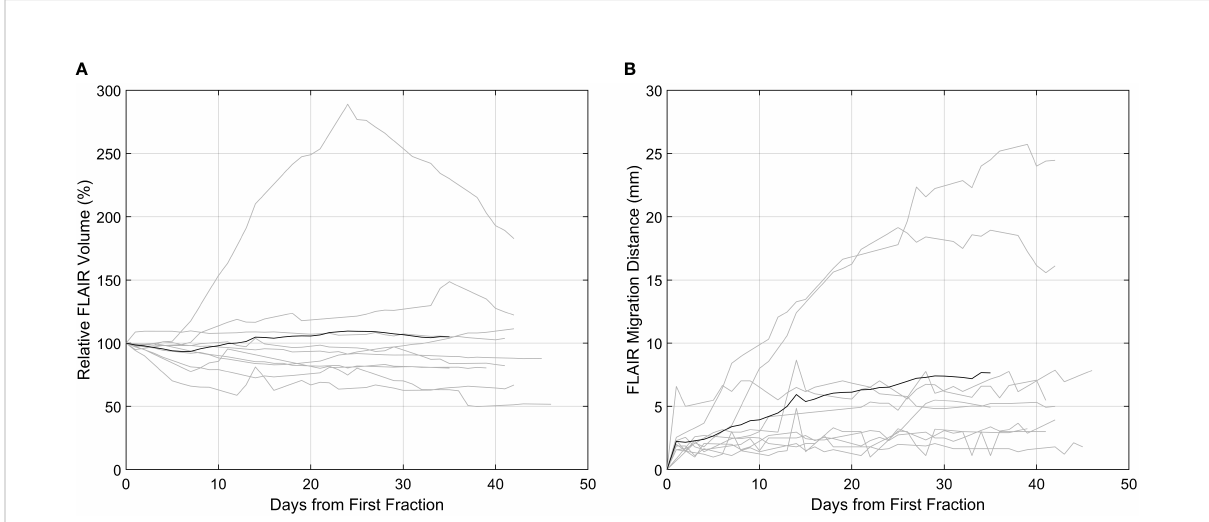
FIGURE 2 FLAIR hyperintense region (FHR) dynamics as captured on the high- fi eld MR-Linac. In both plots, the patients (n = 10) are delineated by the grey lines, and the black line the mean across all patients. (A) T2-FLAIR hyperintense volume relative to the fi rst fraction. (B) The migration distance relative to the fi rst